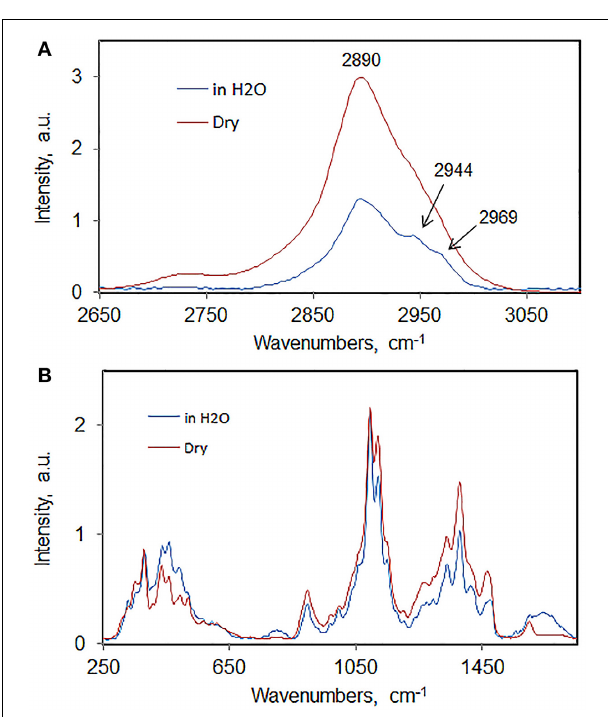
FIGURE 6 | Spectra sets of never-dried and dried aspen woodcellulose; (A) 2650–3100cm − 1 , (B) 250–1550cm − 1 .